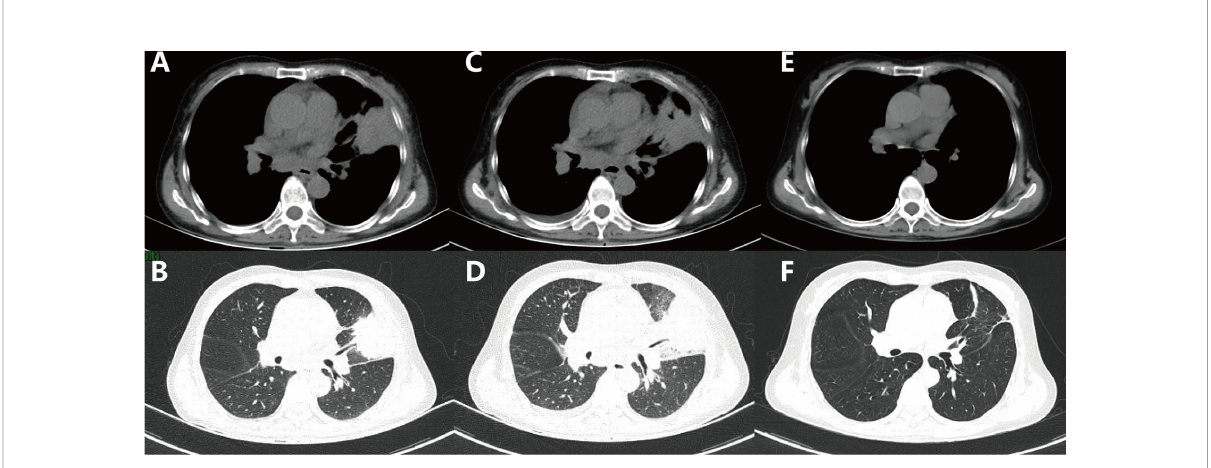
FIGURE 2 Computed tomography scans of the chest showed the following: (A, B) Baseline: lesion in the left lung before treatment. (C, D) One month after the use of osimertinib. (E, F) Thirteen months after the use of erlotinib combined with